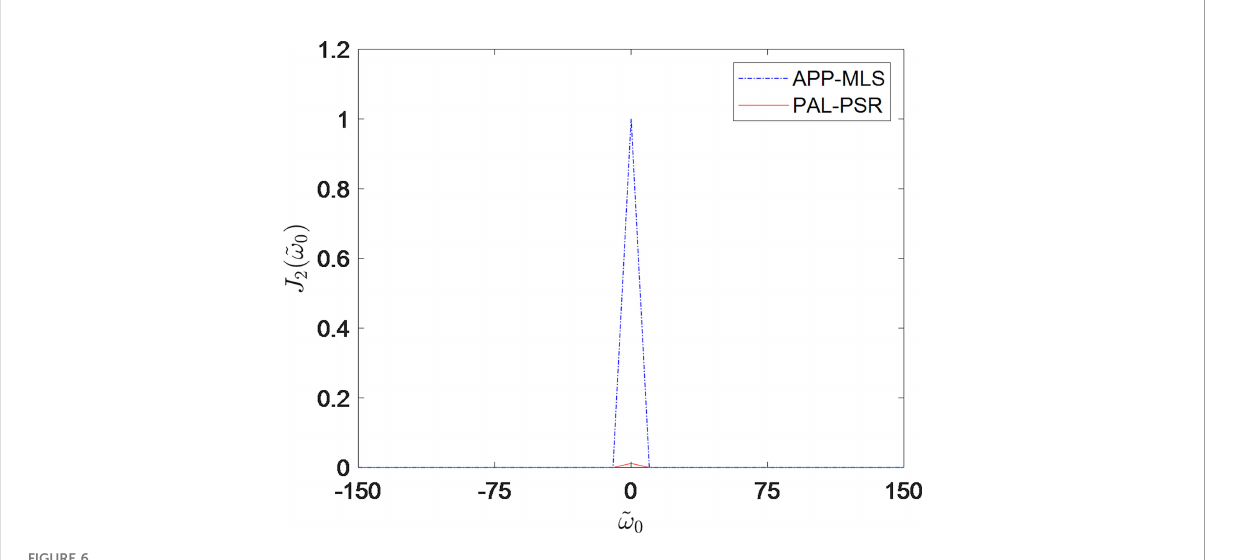
FIGURE 6 ~ w u ) comparison between PAL-PSR and J 2 (